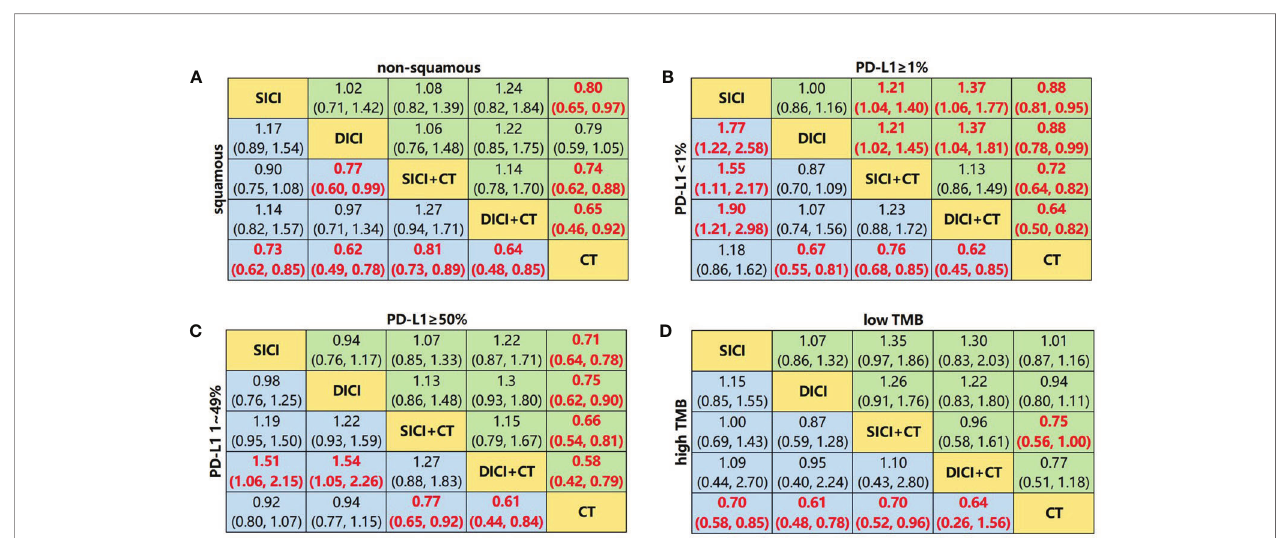
FIGURE 5 | Network meta-analysis for overall survival of subgroup analyses. (A) Pooled hazard ratio (HR) [95% CrIs (credible intervals)] for overall survival (OS) of squamous and non-squamous subgroups. (B) Pooled HR (95% CrIs) for OS of PD-L1 <1% and PD-L1 ≥ 1% subgroups. (C) Pooled HR (95% CrIs) for OS of PD-L1 1% – 49% and PD-L1 ≥ 50% subgroups. (D) Pooled HR (95% CrIs) for OS of high TMB and low TMB subgroups. Data in each cell are HR (95% CrIs) for the comparison of upper row-de fi ning treatment vs . lower row-de fi ning treatment. HR less than 1 favors upper row-de fi ning treatment. Signi fi cant results are highlighted in red and bold. SICI, single immune checkpoint inhibitor; DICI, double immune checkpoint inhibitors; SICI+CT, single immune checkpoint inhibitor combined with chemotherapy; DICI+CT, double immune checkpoint inhibitors combined with chemotherapy; CT,